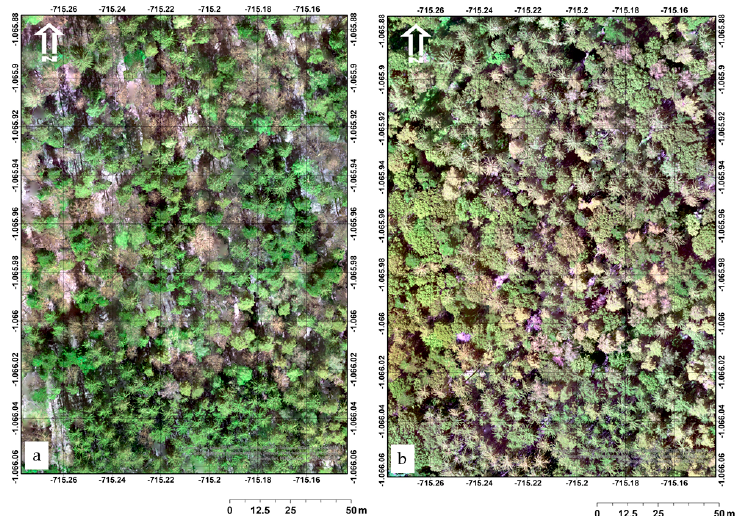
Figure 2. Map perspective of the actual study area. ( a ) Shows the captured ortho-mosaic (RGB) of the study area by UAS at spring and ( b ) shows the captured ortho-mosaic (RGB) of the study area by UAS at summer.